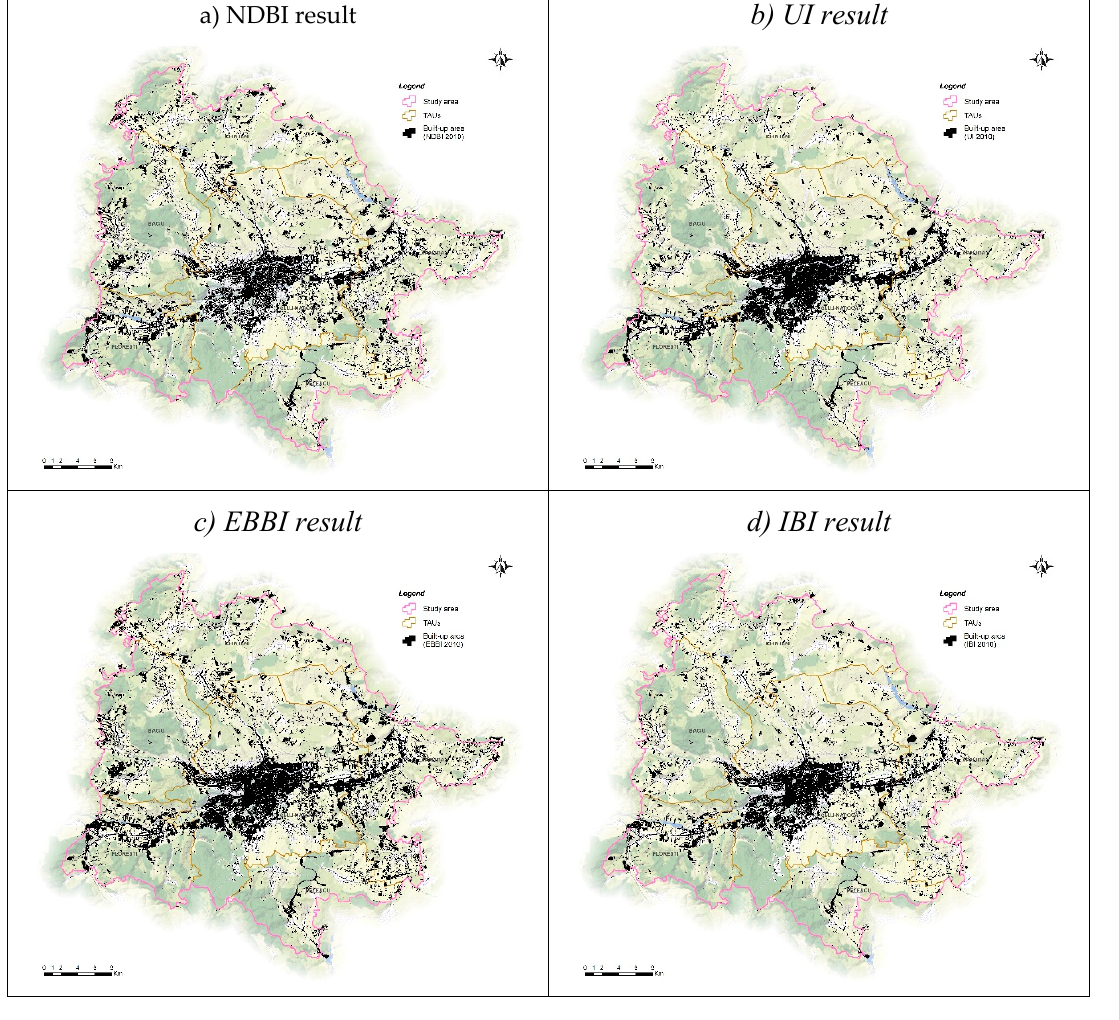
Figure 4. Results obtained using other urban related indices, calculated on Landsat-5 image, acquired in 2010.